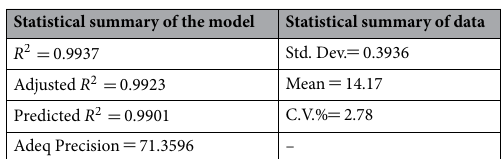
Table 8. The descriptive statistics of the proposed model for cooling range.